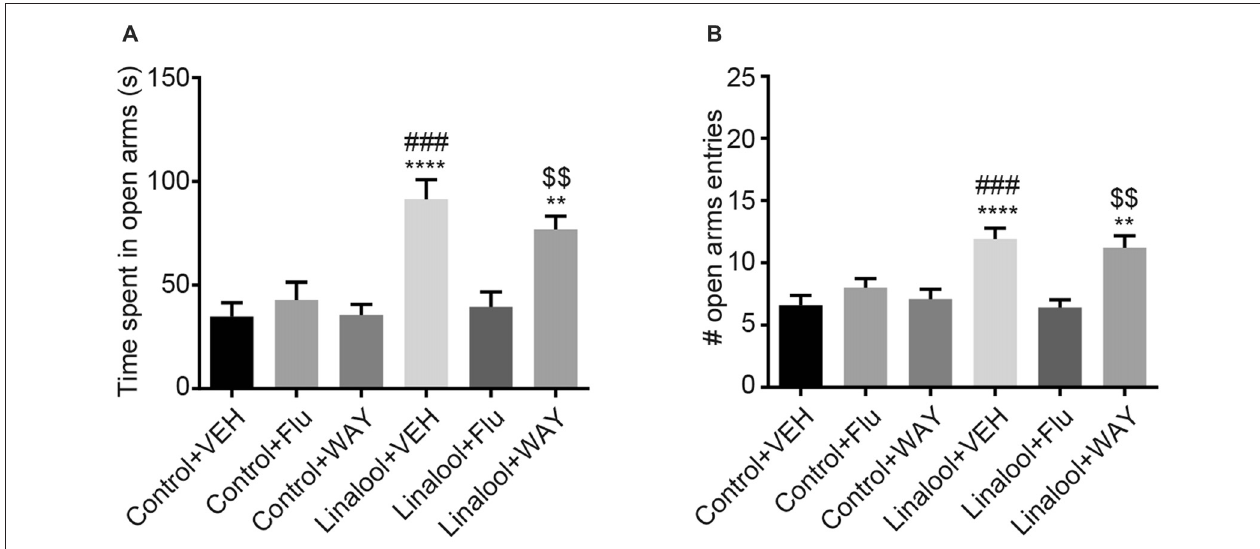
FIGURE 5 | Influence of pretreatment with flumazenil or WAY100635 on the anxiolytic effects of linalool. The increase in time spent in open arms (A) and number of entries to open arms (B) from linalool odor exposure were eliminated in mice treated with flumazenil, but not with WAY100635 in linalool odor-induced anxiolytic effects. Pretreatment with flumazenil or WAY100635 without linalool odor exposure did not affect exploratory behaviors. Control, mice exposed to odorless air; Linalool, mice exposed to 200 µ L of linalool; VEH; mice administered vehicle (2% Tween80 in saline); Flu, mice administered flumazenil (3 mg/kg i.p.); WAY, mice administered WAY100635 (0.5 mg/kg i.p.); each column represents mean ± SEM; n = 10 for all groups. ∗∗ P < 0.01, ∗∗∗∗ P < 0.0001 compared to the Control + VEH group, ### P < 0.001 compared to the Linalool + Flu, $$ P < 0.01 compared to the Control + WAY ( post hoc Tukey’s multiple comparison test).